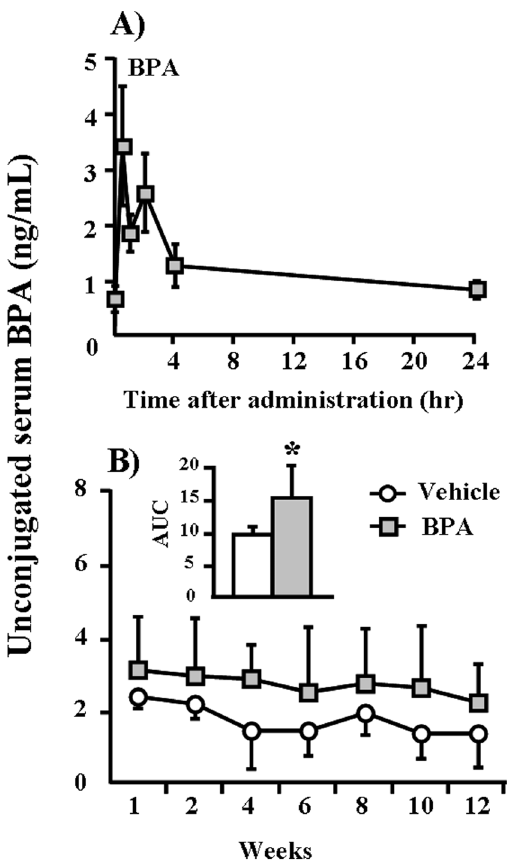
Figure 1. Kinetic changes and accumulation of serum BPA concentrations in WHHL rabbits. (A) WHHL rabbits were fed BPA (400 m g/kg) by gavage, and serum levels of BPA were measured over the next 24 hr as described in the Materials and Methods section. Serum levels of BPA are expressed as the means 6 SE. For each group, n=6. (B) Serum levels of BPA were measured biweekly over the course of 12 weeks as described in the Materials and Methods section. Serum levels of BPA are expressed as the means 6 SD, n=6 for each group. Total exposure volumes during experiments are calculated as the areas under the curves (AUC’s) (shown in the insert). * p , 0.05 vs.